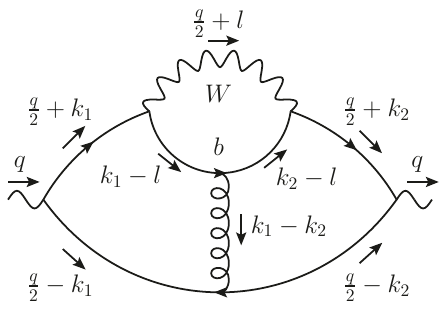
Figure 20 . Forward-scattering diagram whose imaginary part is related to cut diagrams h 1